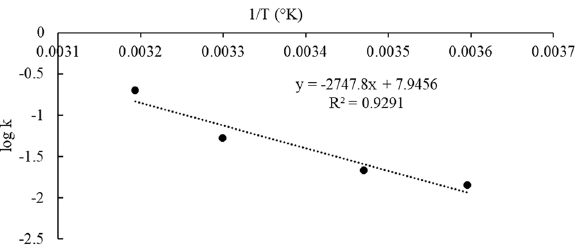
Figure 6. Arrhenius plot of thermal degradation by immobilized Exiguobacterium sp. AO-11 under non- vacuum